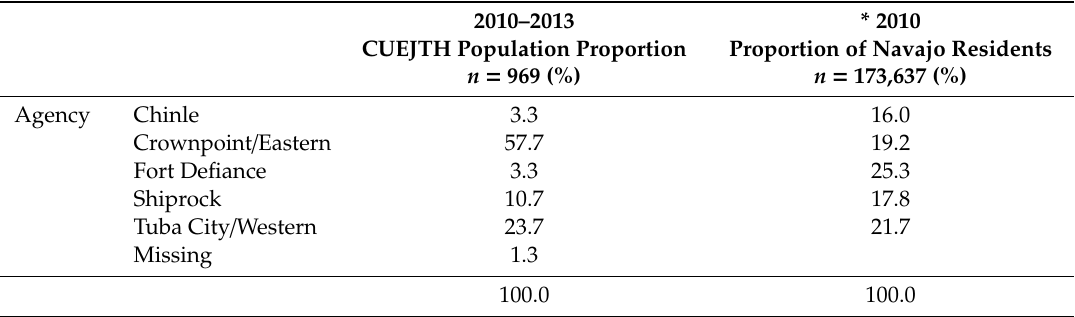
Table 1. Community Uranium Exposure Journey to Healing Program (CUEJTH) Population and Navajo Residents Proportion by Navajo Nation